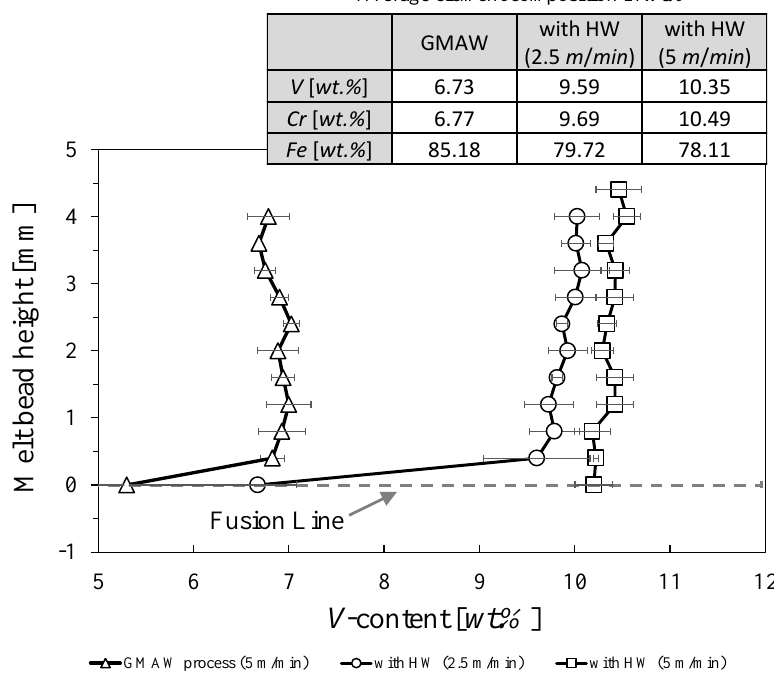
Figure 6. Percentage of V, Cr, and Fe in the hardfacing depending on the hot wire assisted material input.